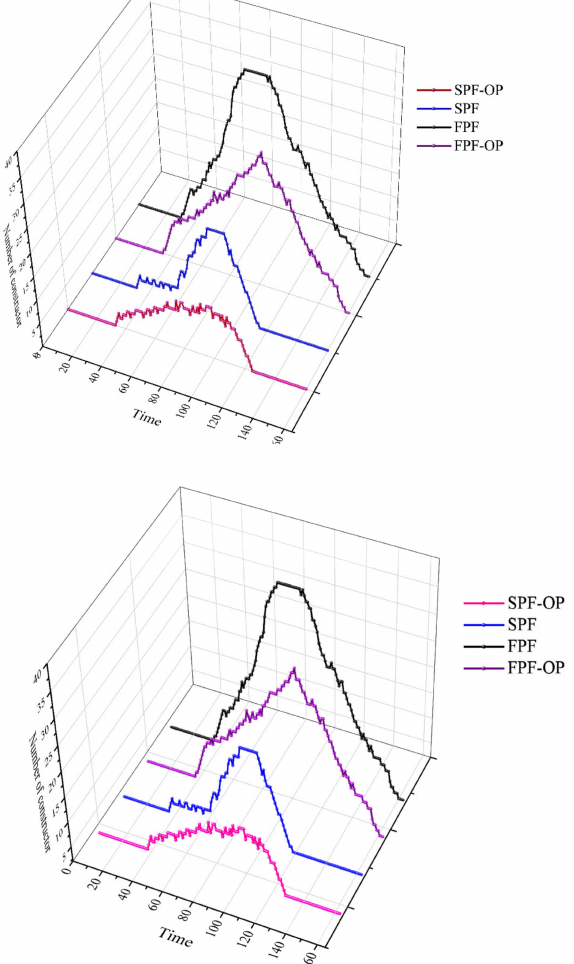
Figure 13. Number of constructors on FPF and SPF platforms with different construction layouts. FPF (first platform of frame working face), SPF (second platform of frame working face), FPF-OP (first platform of frame working face with optimization of construction layout), and SPF-OP (second platform of frame working face with optimization of construction